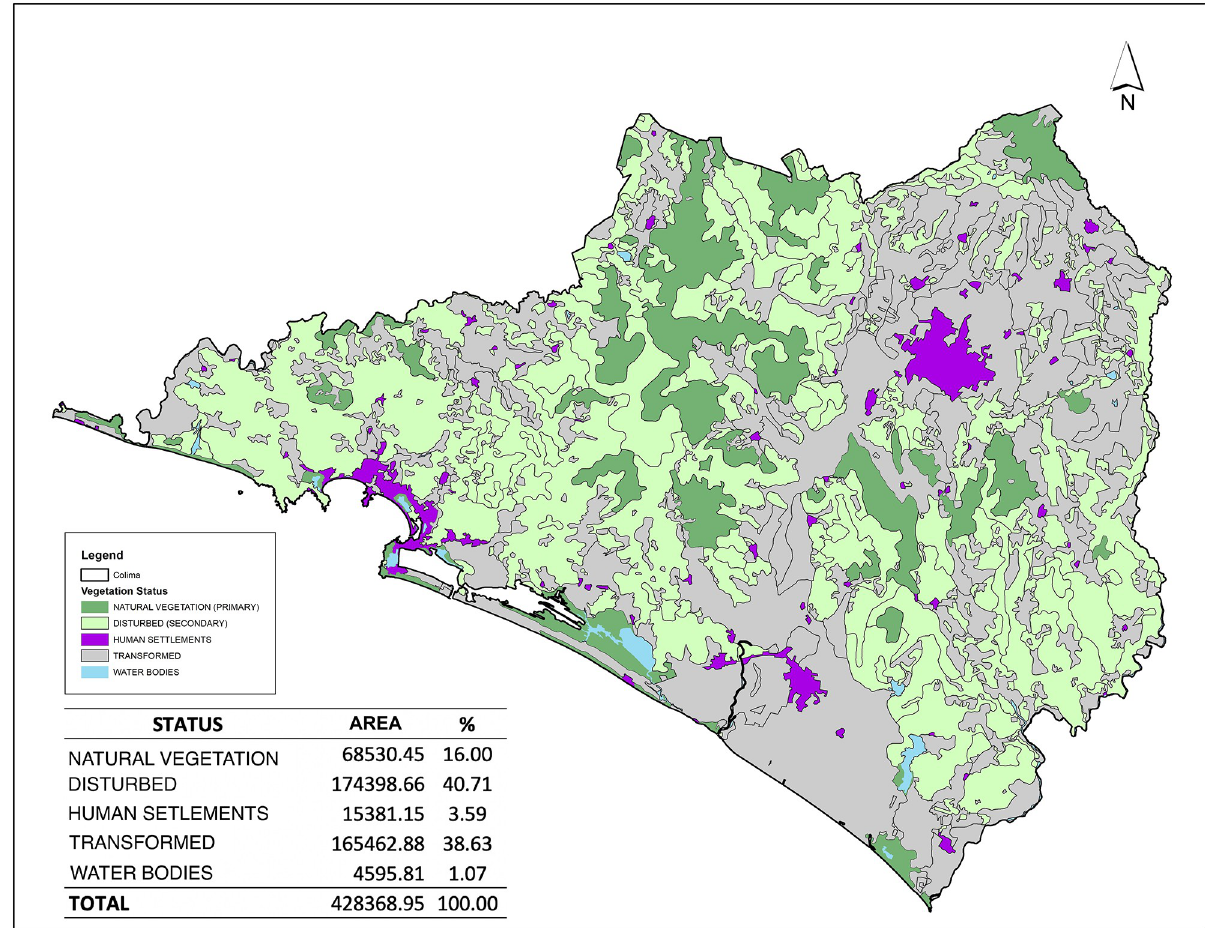
Fig 8. Land use and vegetation. Map were created by A.G. ArcGIS 10.2.1. software